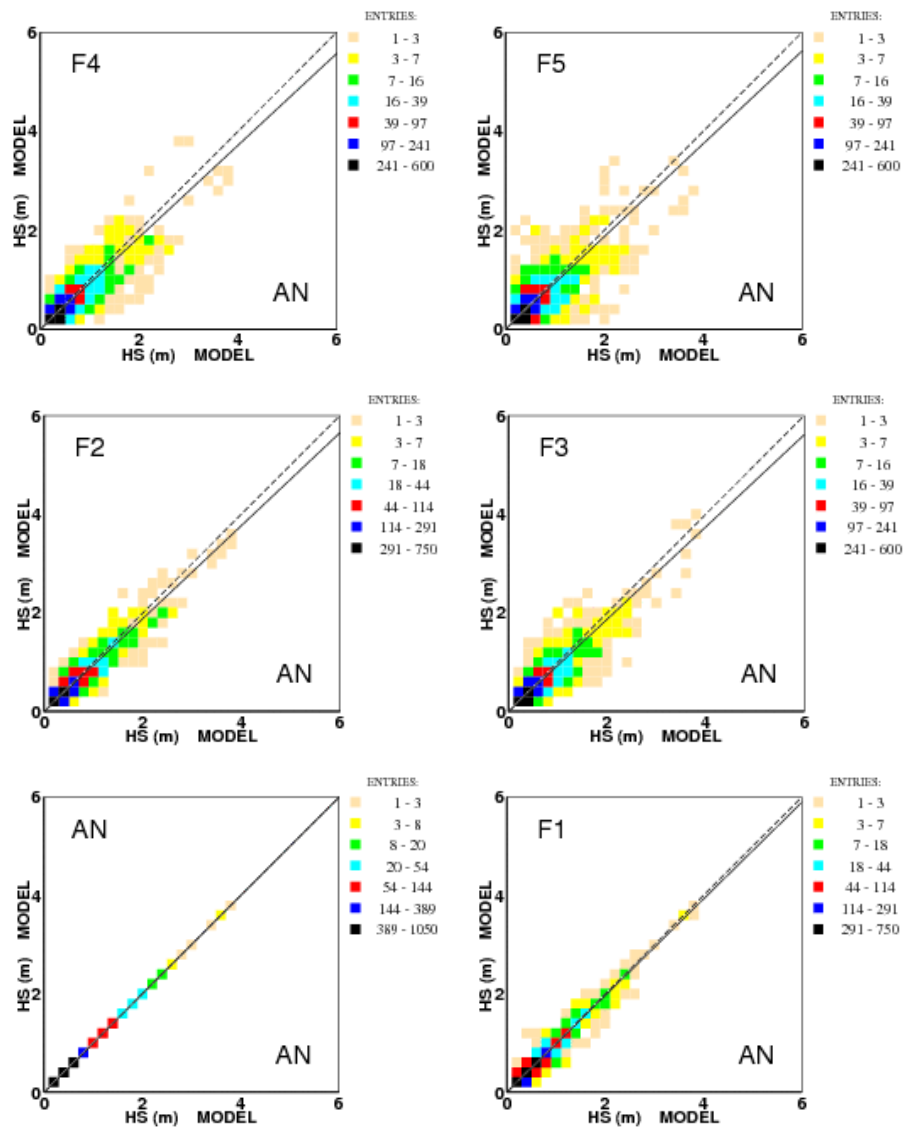
Fig. 12. Scatter diagrams between the significant wave heights out of the model F1=one, F2=two, F3=three, F4=four, F5=five day Figure 12 – Scatter diagrams between the significant wave heights out of the model F1=one, forecasts and the corresponding analysis (AN). The considered period is F2=two, F3=three, F4=four, F5=five day forecasts and the corresponding analysis (AN). The Figure 12 – Scatter diagrams between the significant wave heights out of the model F1=one, considered period is 2010. F2=two, F3=three, F4=four, F5=five day forecasts and the corresponding analysis (AN). The Figure 12 – Scatter diagrams between the significant wave heights out of the model F1=one, considered period is 2010. F2=two, F3=three, F4=four, F5=five day forecasts and the corresponding analysis (AN). The considered period is 2010.